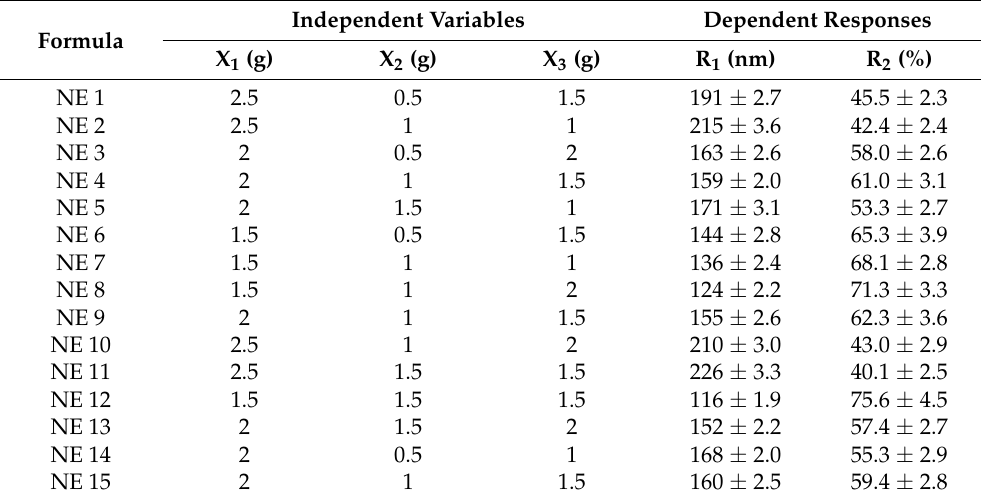
Table 1. Experimental design for various FA-loaded NEs, along with their detected values of response. Formula